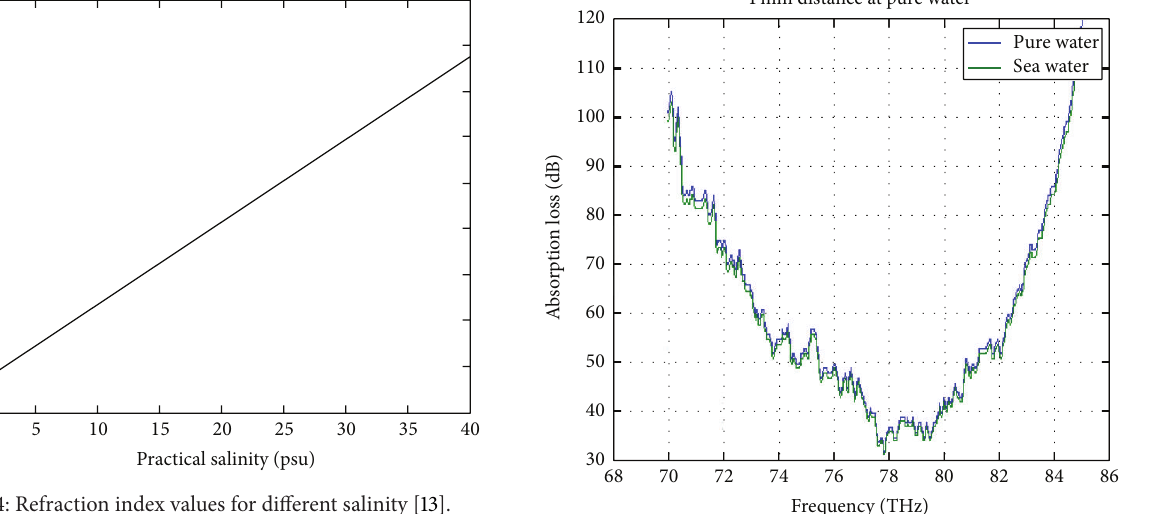
Figure 4: Refraction index values for different salinity [13].